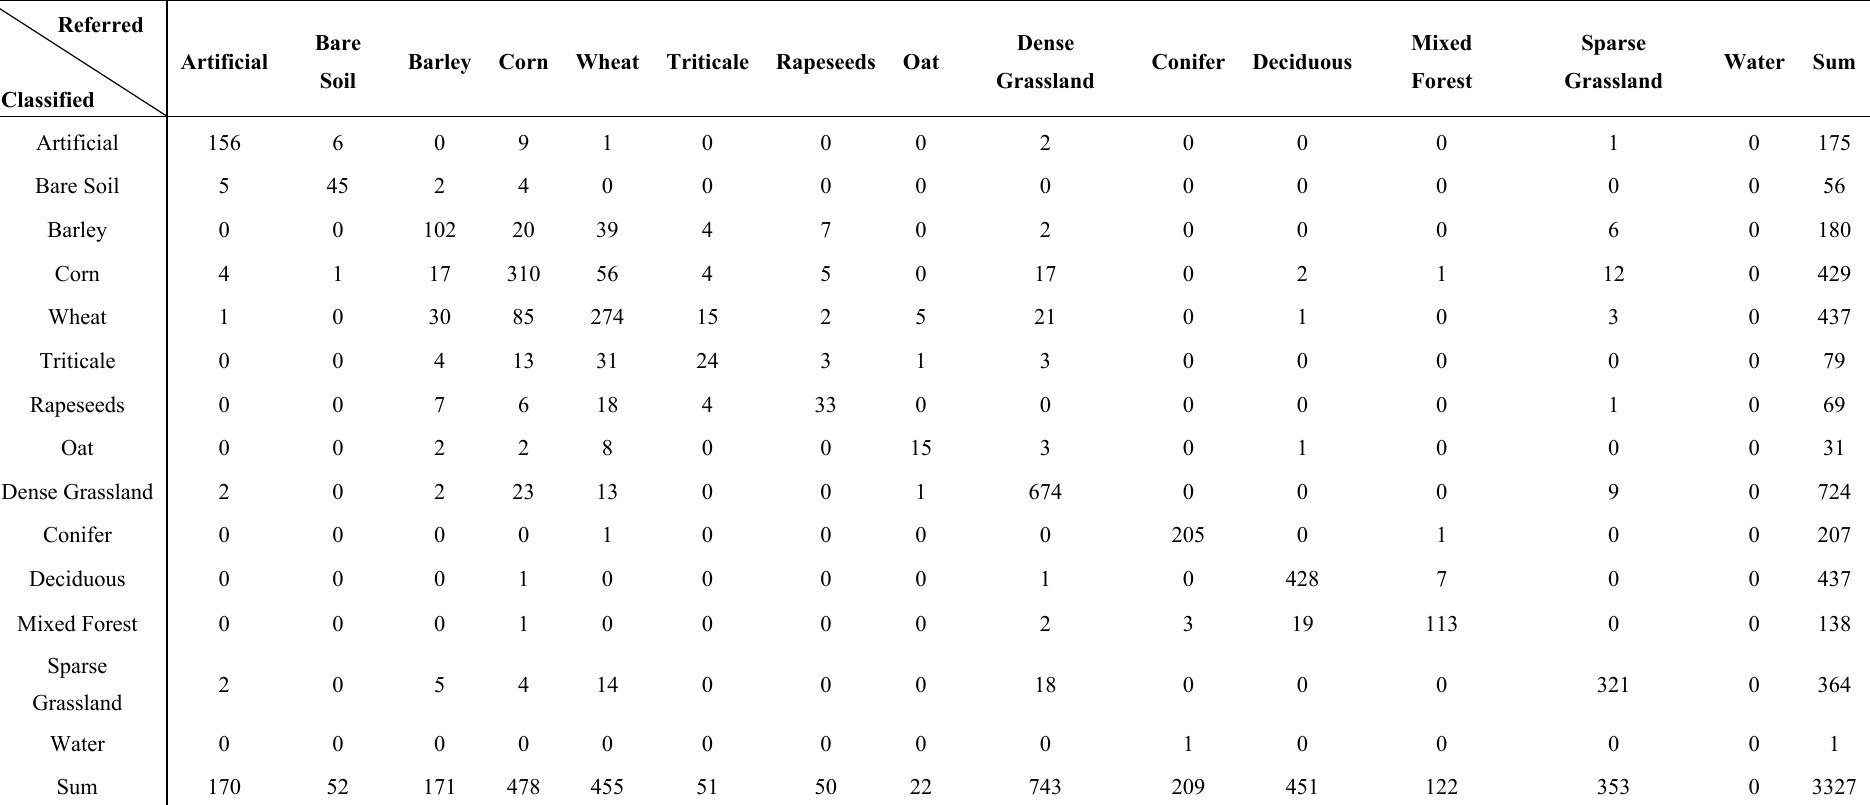
Table 6. Confusion matrix for the Level 3 category of single Landsat 8 image in July 2013 with 10 bands combination. The column indicates the referred data points for the 14 classes from field campaign and the row represents the classified data by Random